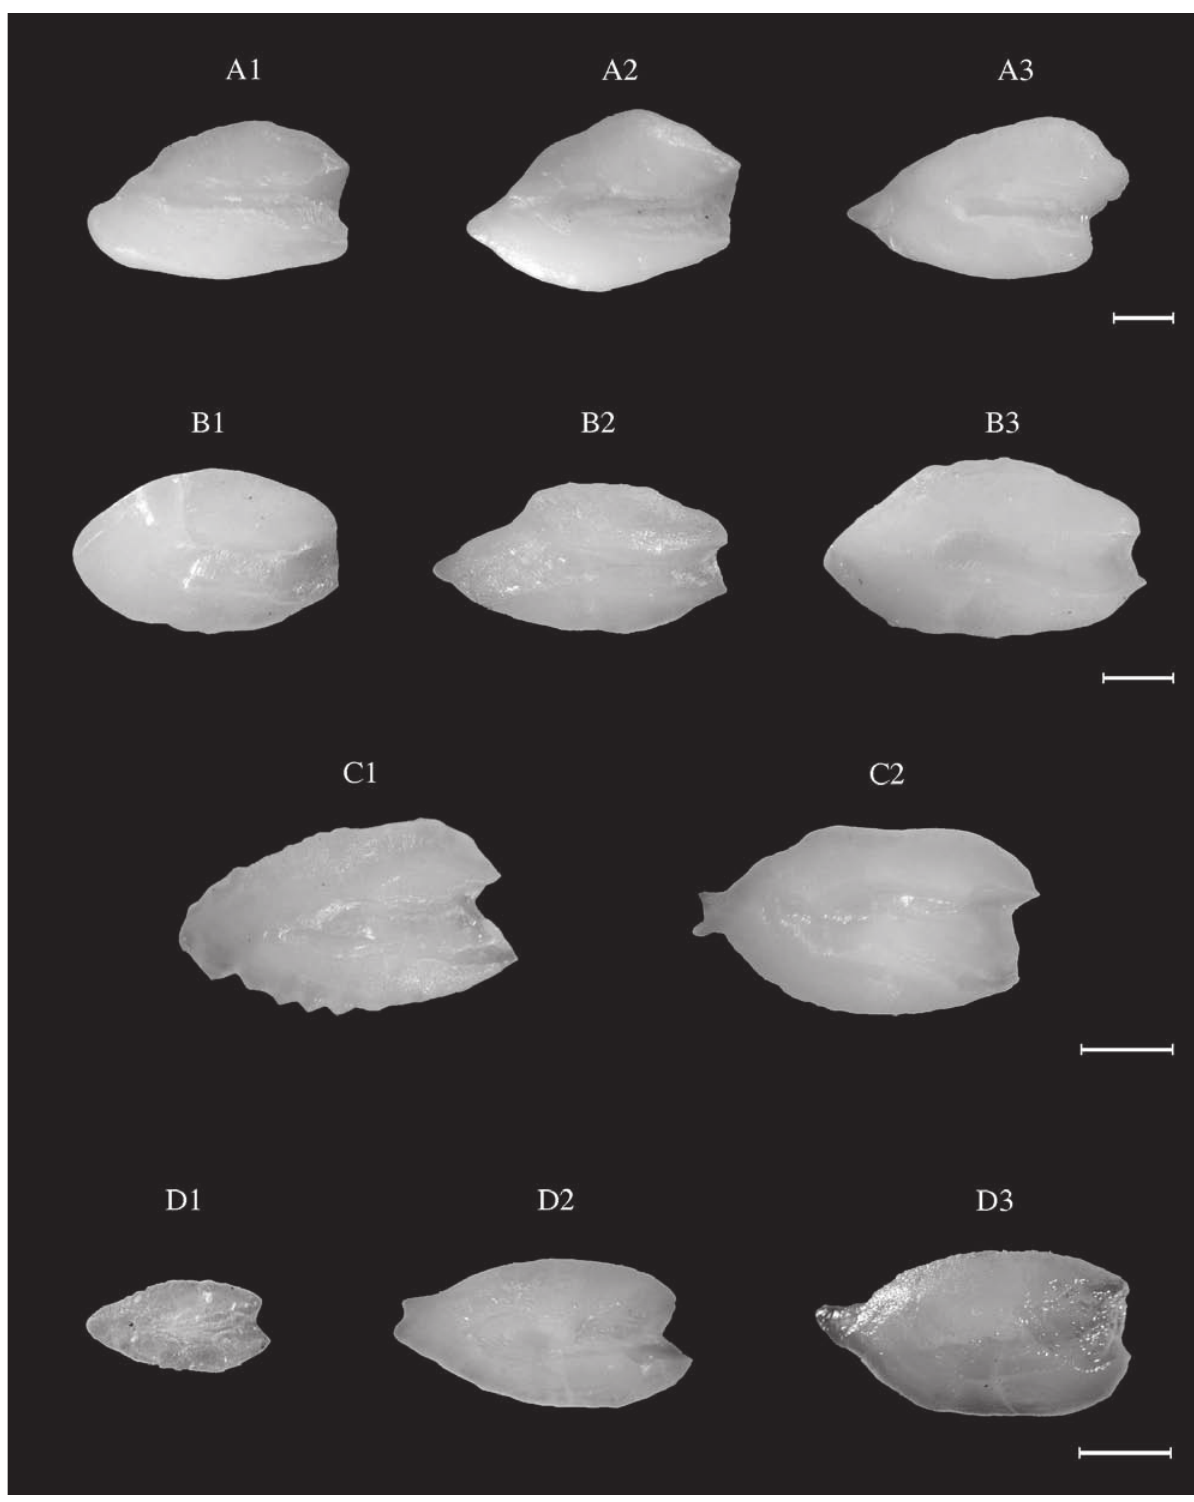
Fig. 11. – Gymmnothorax maderensis (CEA). TL: A1, 93.9 cm; A2, 95.5 cm; A3, 98.1 cm. Gymmnothorax polygonius (CEA). TL: B1, 58.0 cm; B2, 61.6 cm; B3, 91.0 cm. Gymmnothorax. unicolor (CEA). TL: C1, 70.4 cm; C2, 71.2 cm. Muraena augusti (CEA). TL: D1, 29.8 cm; D2, 65.4 cm; D3, 66.4 cm. Scale bar = 1